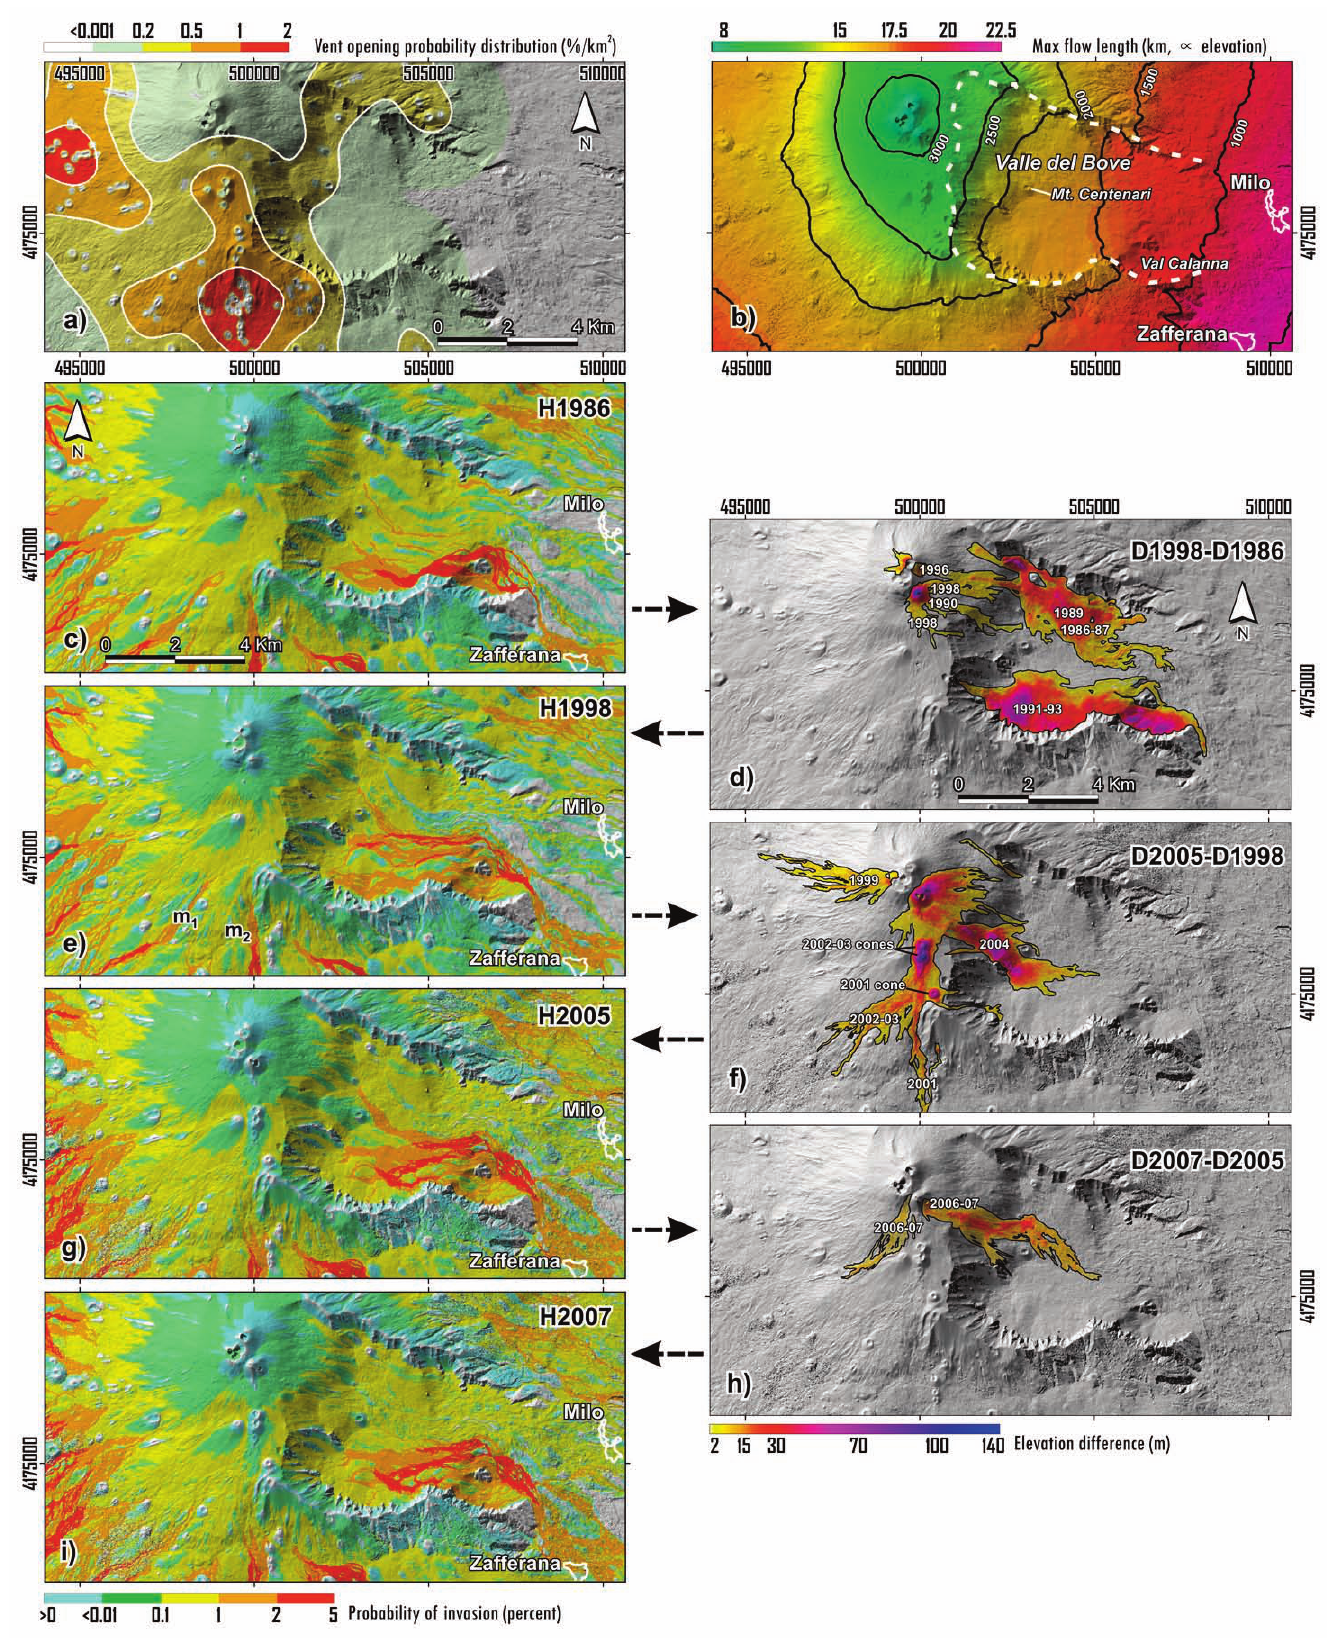
Figure 7. a) Map of the vent-opening probability used in Equation (1) (see main text), modified after Tarquini and Favalli [2010]; b) Map of the maximum expected length for future lava flows as a function of the vent elevation (modified after Tarquini and Favalli [2010]); c), e), g), i) Hazard maps of a portion of Mount Etna including the Valle del Bove, based on the 1986, 1998, 2005 and 2007 DEMs, respectively. d), f), h) Maps of the differences between the 1998 and 1986 DEMs, 2005 and 1998 DEMs, and 2007 and 2005 DEMs, respectively. Colored areas represent the main lava flows and scoria cones formed over each time interval (the noise outside these main changes has been masked